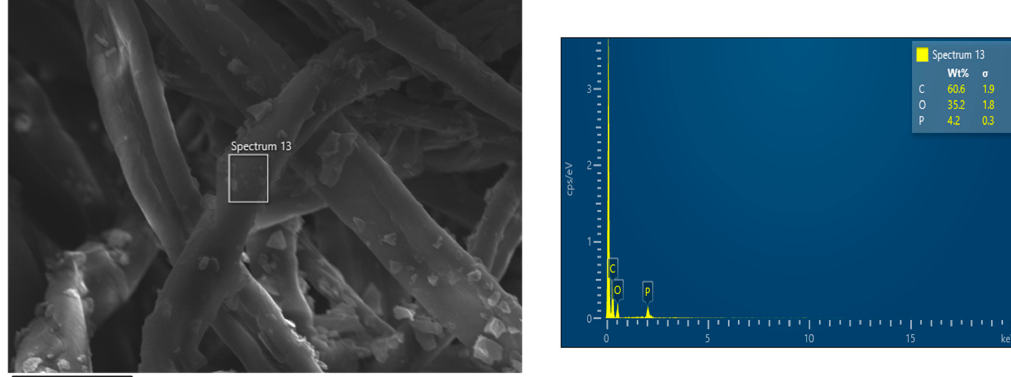
Figure 11. HRR vs. time curves for cotton and for COT+PA+BC(8) before and after washing (heat flux: 35 kW/m 2 ).